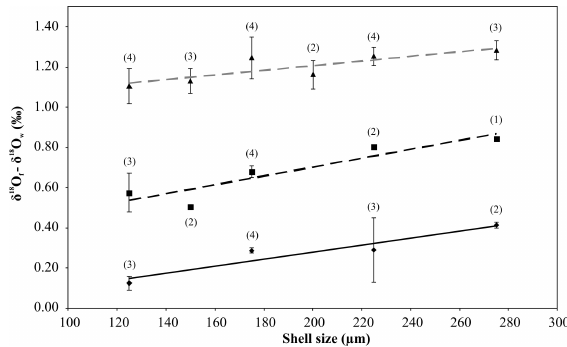
Fig. 2. Shell size effect on the oxygen isotopic composition ( δ 18 O f − δ 18 O w ) of B. marginata calcified in culture at 10.2 (trian- gles), 12.7 (squares) and 14.7 ◦ C (diamonds). The number of mea- surements for each average value is indicated in parenthesis. The linear regressions are: y = 0.0012x + 0.9745 ( R 2 = 0.40; p = 0 . 003; gray dashed line) at 10.2 ◦ C; y = 0.0022x + 0.2655 ( R 2 = 0.71; p = 0 . 001; black dashed line) at 12.7 ◦ C; and y = 0.0017x + 0.0588 ( R 2 = 0.57; p = 0 . 005; black line) at 14.7 ◦